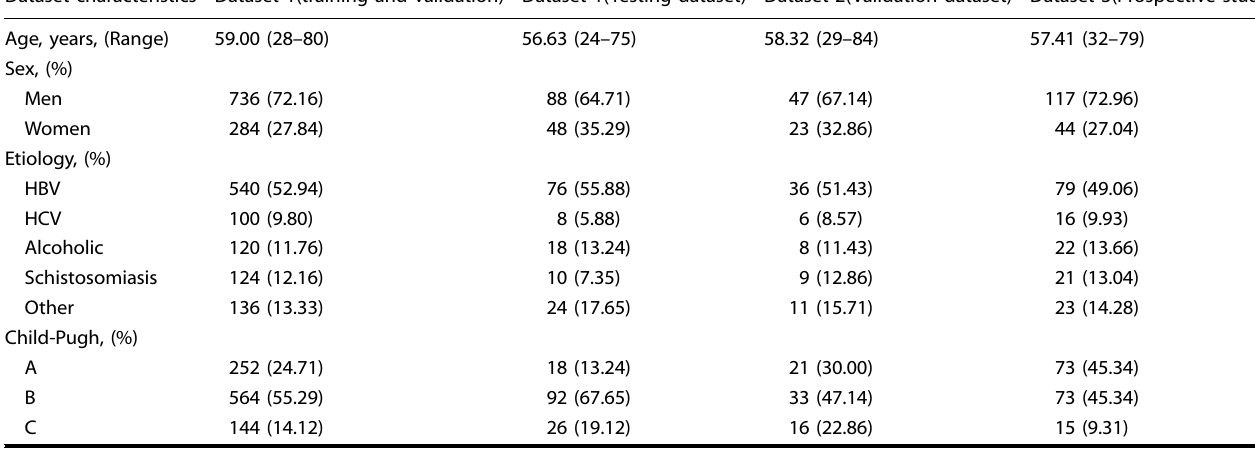
Table 1. Clinical characteristics of